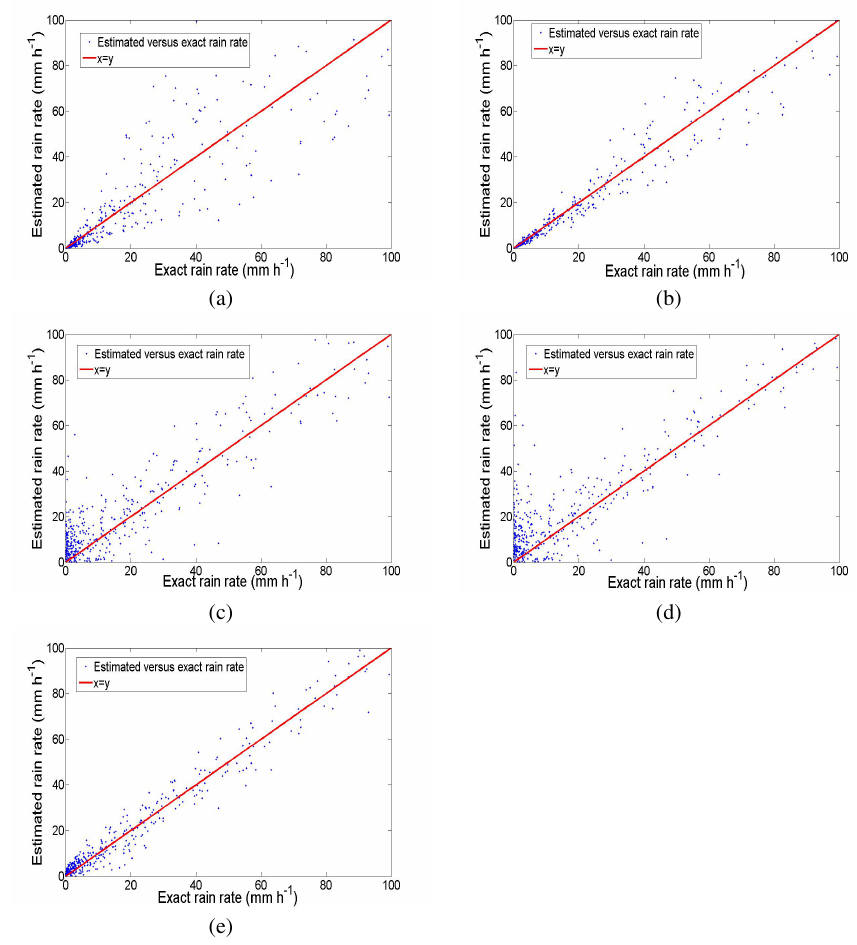
Figure 4. Estimated versus exact rain rate. (a) R ( Z ), (b) R ( Z , Z dr ), (c) R ( K dp ), (d) R ( K dp , Z dr ), (e) R ( Z , K dp , Z dr ).